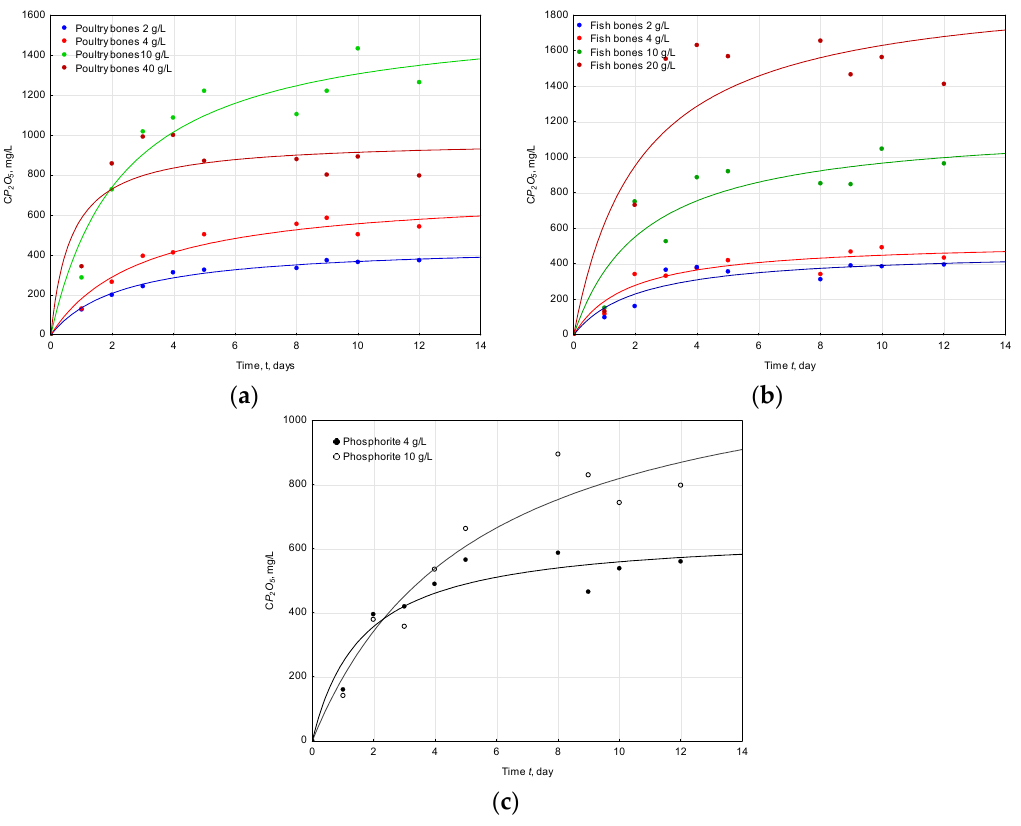
Figure 1. Changes of phosphorus (expressed as P 2 O 5 ) concentrations during the solubilization performed by A. ferrooxidans with the utilization of three different phosphorus raw materials ( a ) poultry bones; ( b ) fish bones; and ( c ) phosphorite.